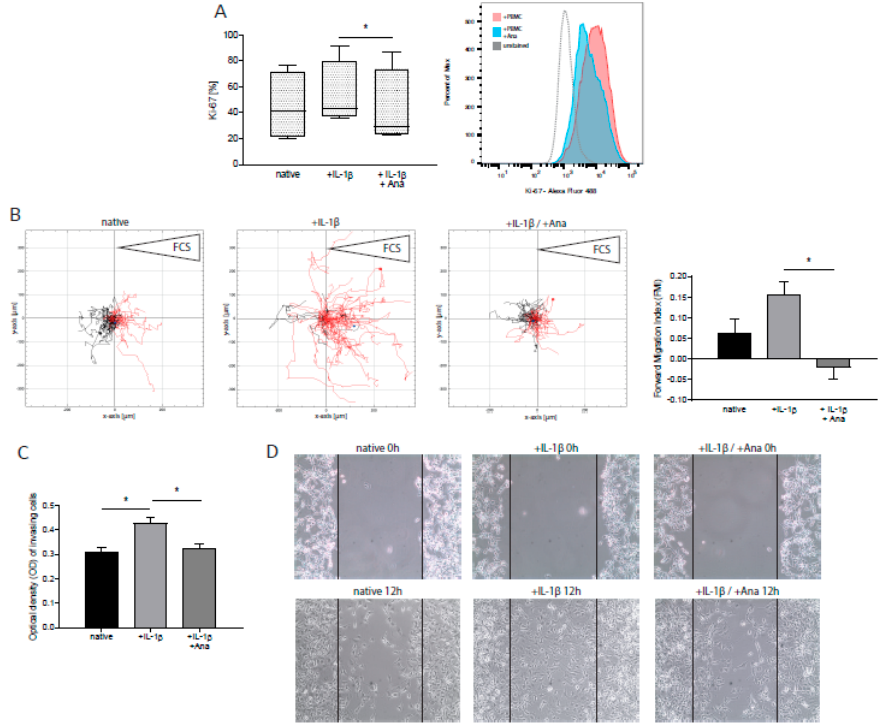
Figure 2. GBM proliferation, migration, and invasion, promoted by IL-1 β stimulation, was mitigated after treatment with anakinra (Ana). T98G cells were stimulated with IL-1 β in the presence or absence of anakinra. ( A ) Quantification of Ki-67-positive T98G cells by flow cytometry (n = 5, p = 0.027). One representative histogram is shown. ( B ) Analysis of chemotaxis time-lapse microscopy by single-cell tracking. IL-1 β -stimulated T98G cells were incubated with FCS as a chemotactic stimulus (right reservoir). At least 40 cells were tracked. One representative example of four independent experiments is shown (left panel, n = 4). Analysis of forward migration index (FMI, coordinate of a cell in the indicated direction (x-axis) divided by the accumulated distance of its paths, representing efficiency of forward migration) (right panel, n = 4, p = 0.048). ( C ) Analysis of tumor cell invasion by transwell invasion assay. Stimulated T98G cells were seeded in cell culture inserts and allowed to migrate towards FCS as a chemotactic stimulus. Optical density of invasive T98G represents the amount of transmigrated cells (n = 3, p < 0.05). ( D ) 2D migration assay of GBM cells, stimulated with IL-1 β in the presence or absence of anakinra at start and after 12h. Lines mark the initially cell-free area. A typical example of six experiments is shown (n = 6). * p <